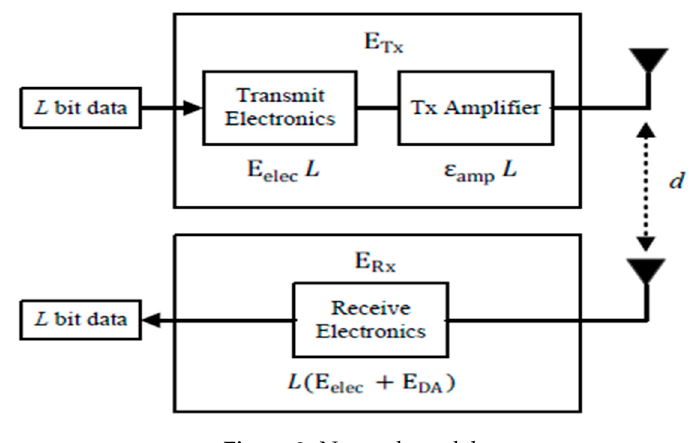
Figure 2. Network model. Figure 2. Network